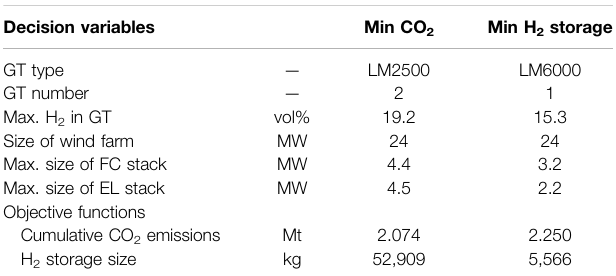
TABLE 5 | Optimal designs of the constant FC and EL performance case - Pareto